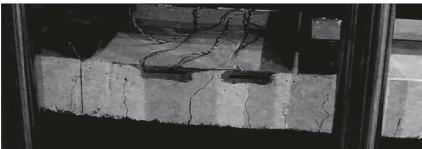
Figure 5: Crack pattern of the specimen